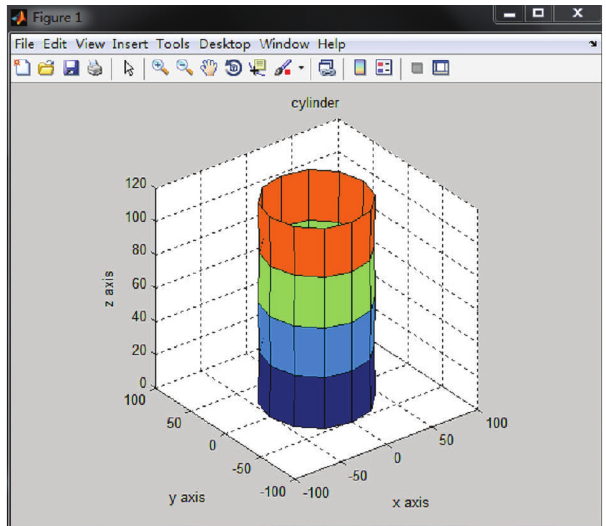
Figure 9: The 3D cylinder of measuring points.